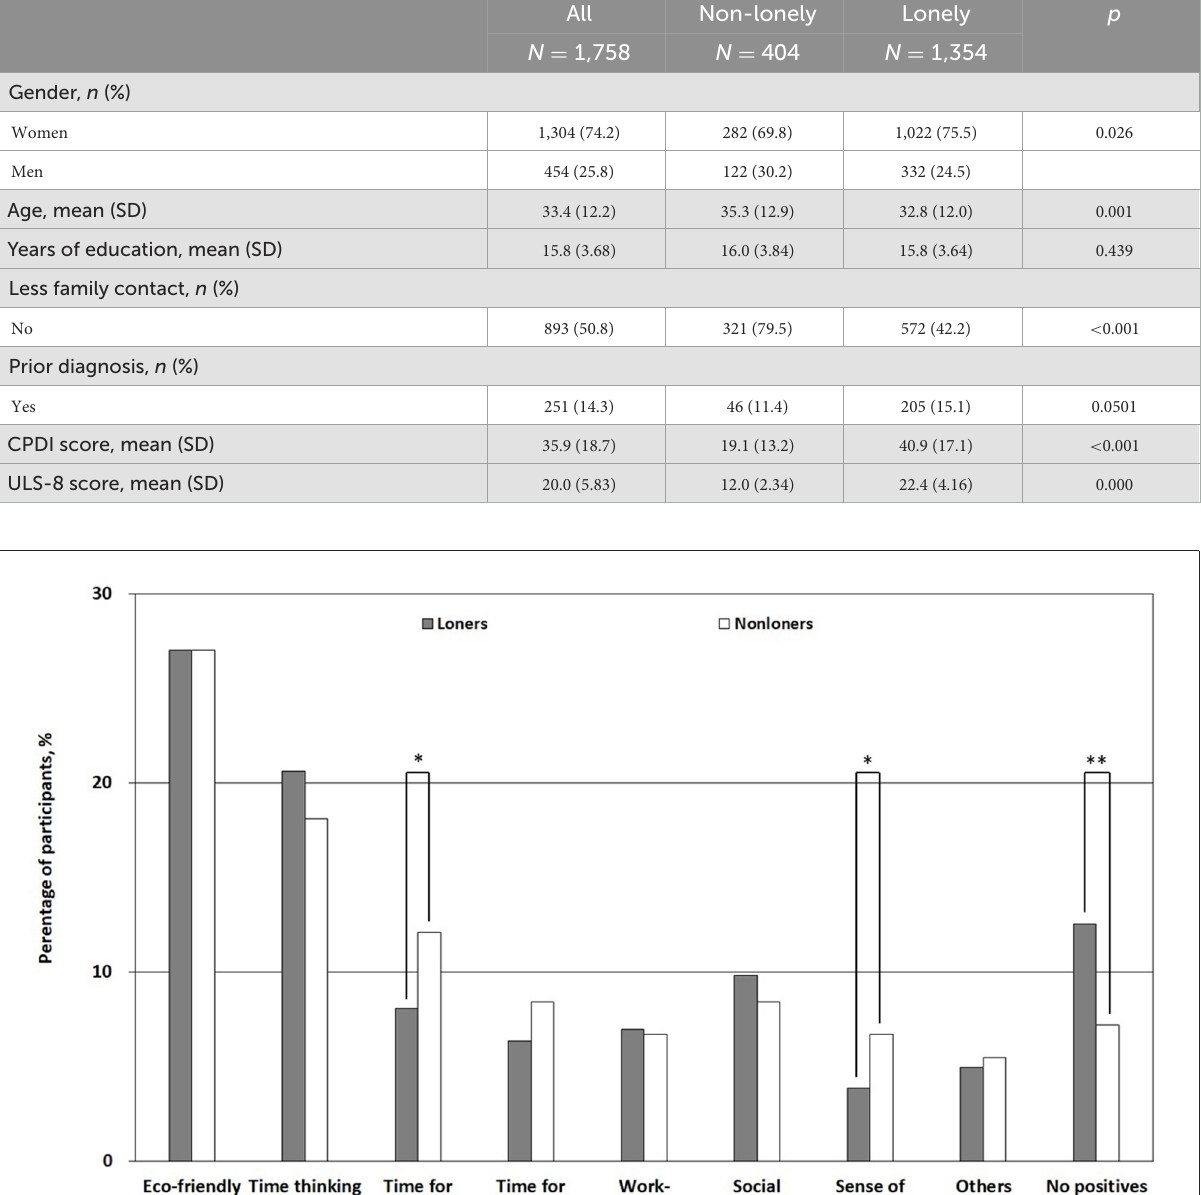
= 0.11, p = 0.74]. Overall, our logistic as threatening [ χ 2 (1) regression showed that age [ z (1,756) = 0.15, p = 0.88] and gender [ z (1,756) = − 1.9, p = 0.057] were not associated with conspiracy belief, whereas loneliness score was associated with conspiracy belief [ z (1,756) = − 3.35, p <